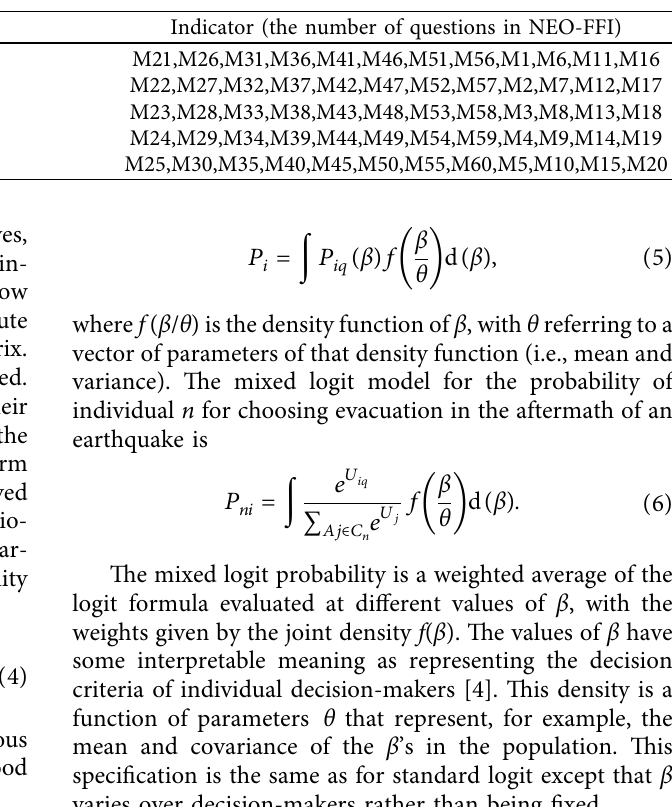
Table 3: The structure of latent variables and